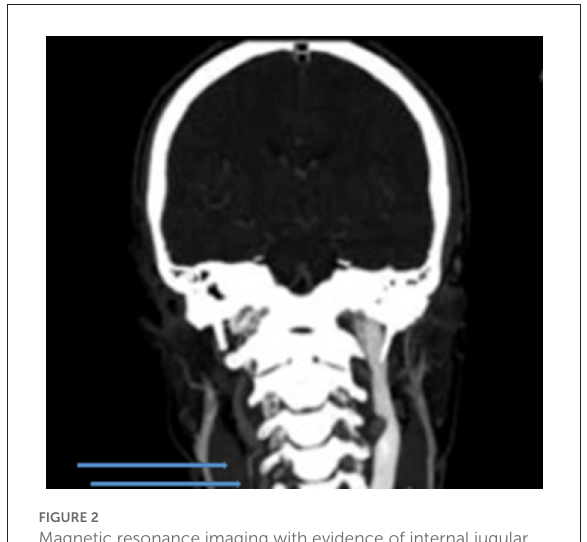
FIGURE2 Magnetic resonance imaging with evidence of internal jugular